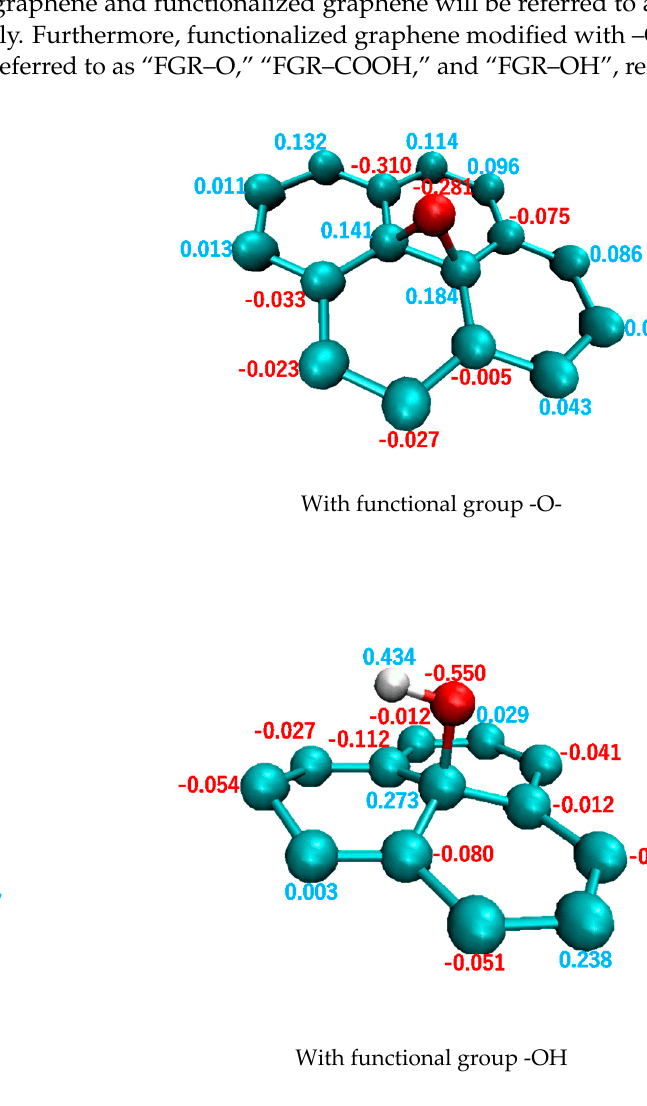
Figure 6. Charge distributions in a repeating unit of graphene and a region around the functional group of functionalized graphene.